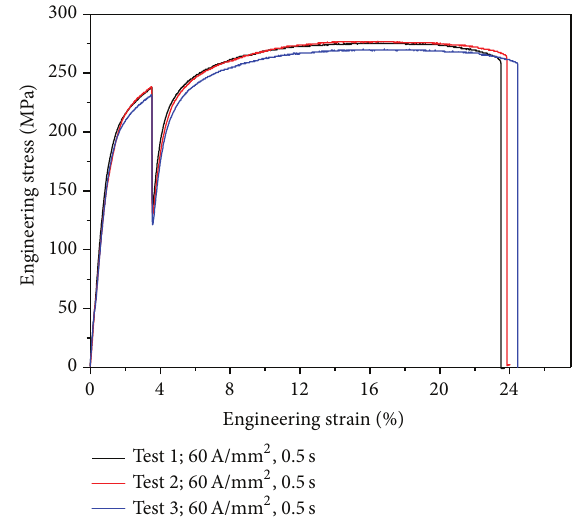
Figure 2: The repeatability of experimental result: 𝜌 𝑖 𝑜 = 60 A/mm 2 , 𝑡 𝑑 = 0.5